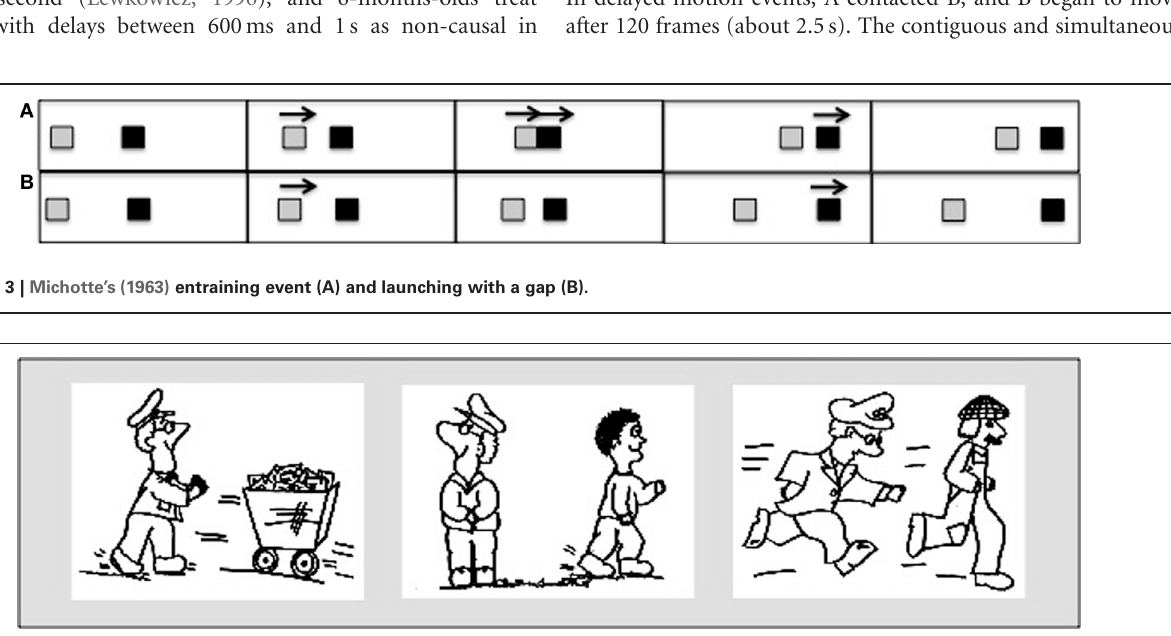
FIGURE 4 | Choice pictures for physical causality, non-causality, and social